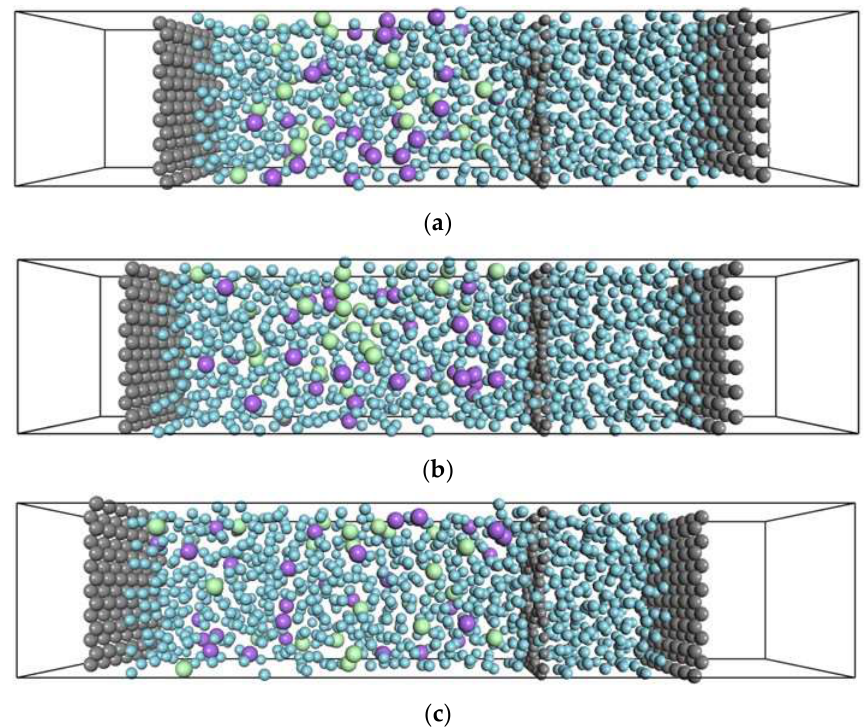
Figure 2. Snapshots of the unit cell from the NEMD results at ( a ) 1, ( b ) 2, and ( c ) 3 ns. The solute concentration is 9.1%.